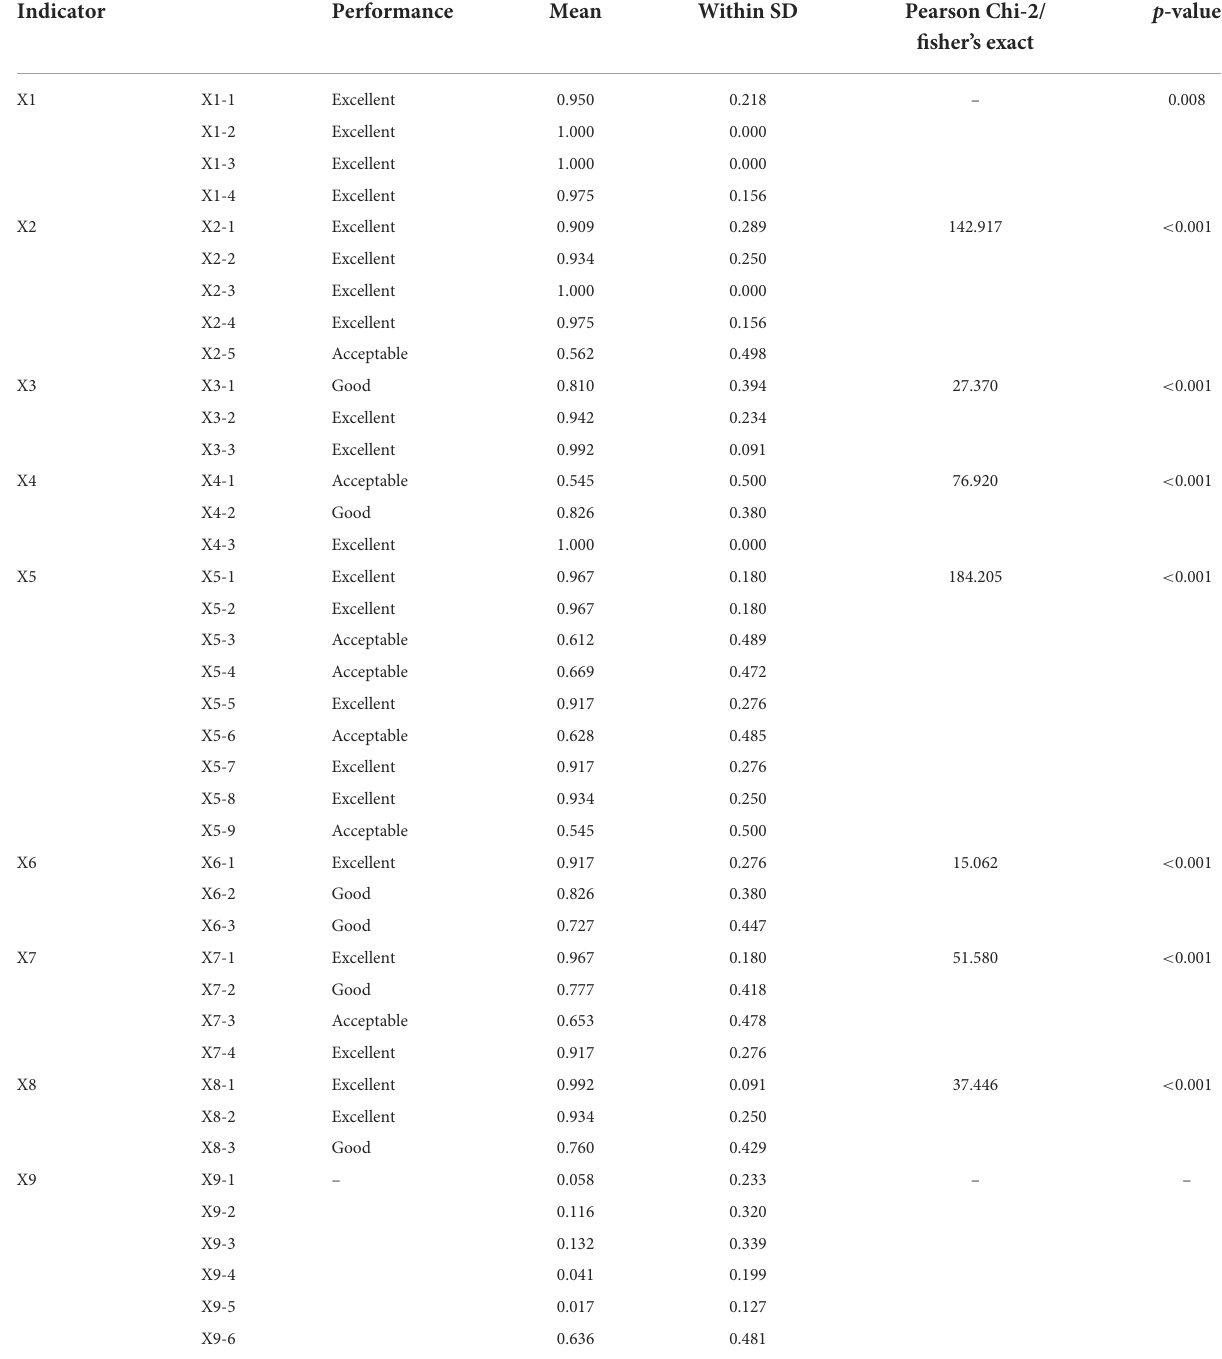
TABLE 5 Mean values of second-level indicators in different dimensions.